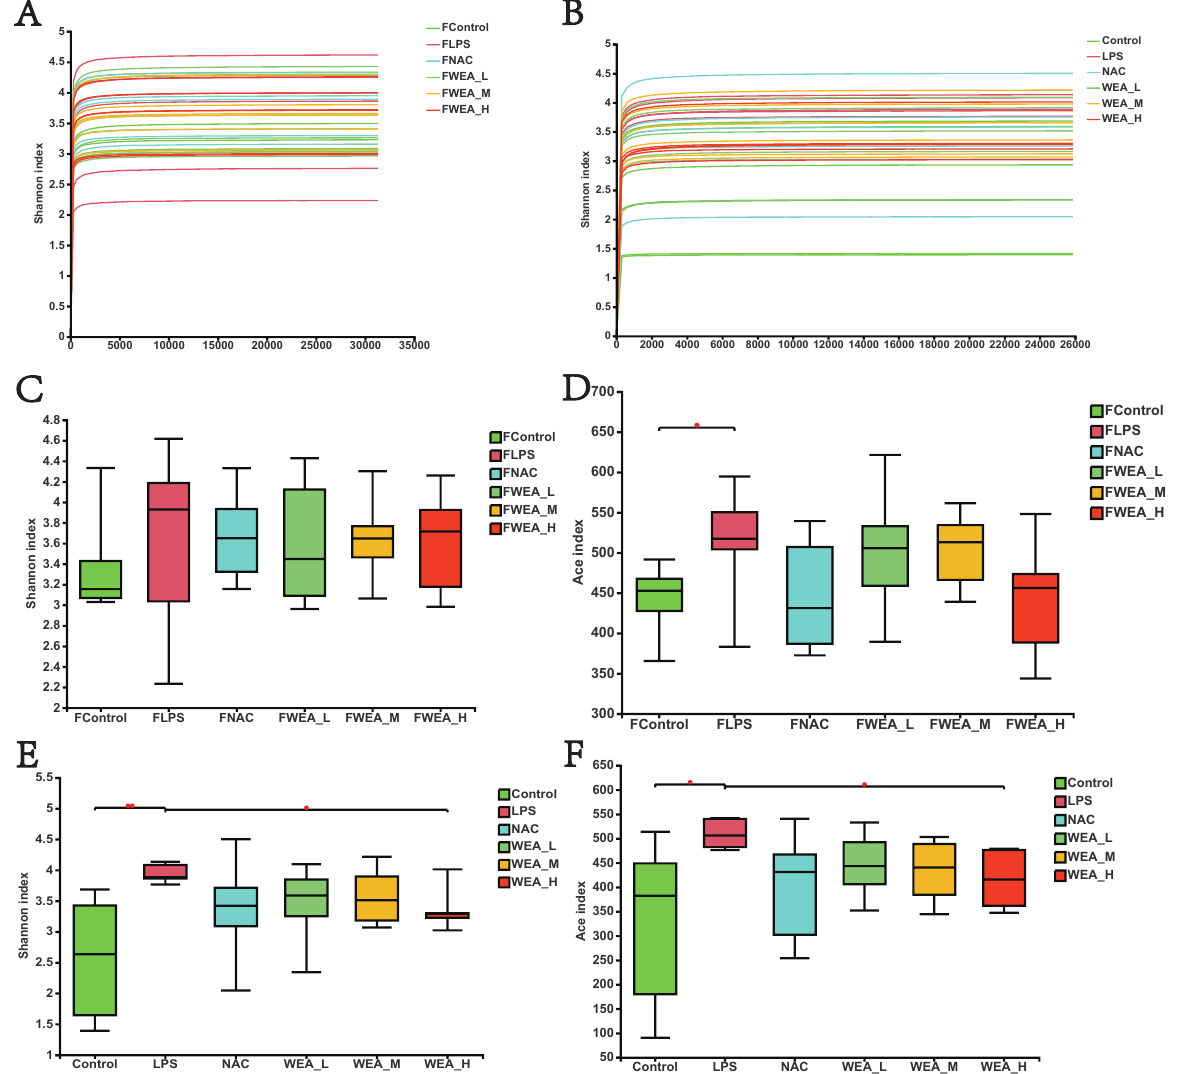
Figure 7. Gut microbiota alpha diversity. ( A , B ) Bacterial Shannon index curve, ( C – F ) alpha diver- sity analysis in the feces ( A , C , D ), and intestinal digesta ( B , E , F ). FLPS = 10 mg/kg lipopolysaccha- ride; FNAC = 300 mg/kg N-acetylcysteine; FWEA_L = 50 mg/kg water extract of A. grossedentata; FWEA_M = 100 mg/kg water extract of A. grossedentata; FWEA_H = 200 mg/kg water extract of A. grossedentata; LPS = 10 mg/kg lipopolysaccharide; NAC = 300 mg/kg N-acetylcysteine + 10 mg/kg lipopolysaccharide; WEA-L = 50 mg/kg water extract of A. grossedentata + 10 mg/kg lipopolysac- charide; WEA-M = 100 mg/kg water extract of A. grossedentata + 10 mg/kg lipopolysaccharide; WEA-H = 200 mg/kg water extract of A. grossedentata + 10 mg/kg